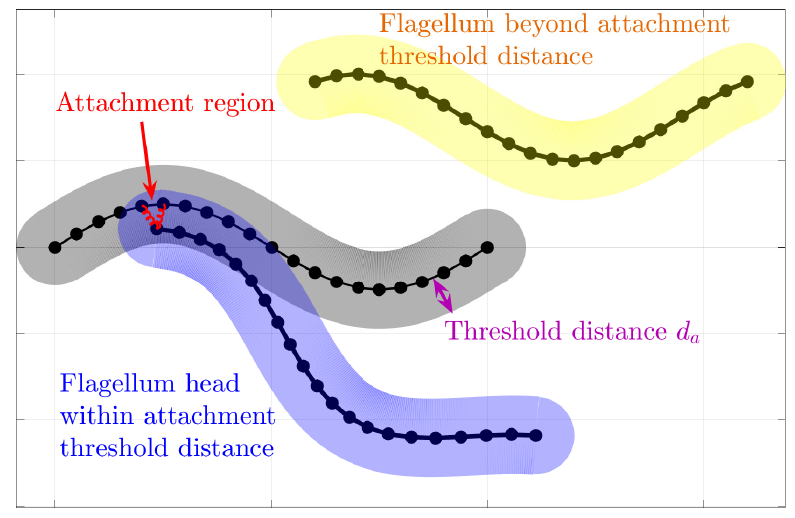
Figure 3. Schematic detailing the sperm train attachment model